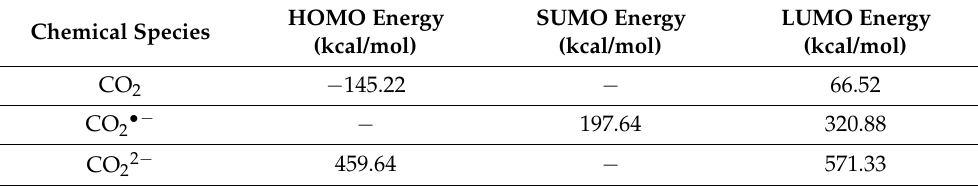
Table 3. HOMO, SOMO, and LUMO energy values for species involved in CO 2